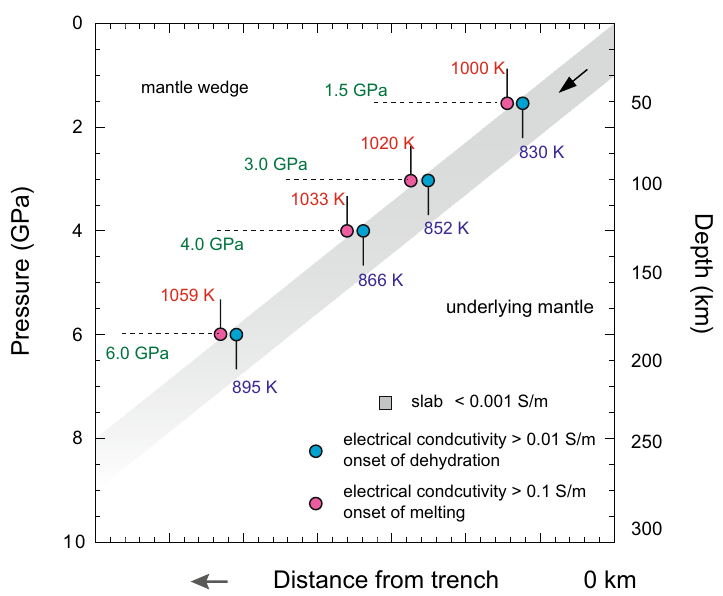
Figure 7. The electrical conductivity based geothermometer. The locus of dehydration of glaucophane in the slab is shown in blue circles and the locus of melting of glaucophane is shown in pink circles. The characteristic electrical conductivity at dehydration of glaucophane is 0.01 S/m, the electrical conductivity at the onset of melting of glaucophane is 0.1 S/m. In comparison, the electrical conductivity of the hydrous slab is about 0.001 S/m. The corresponding slab surface temperatures are shown at different